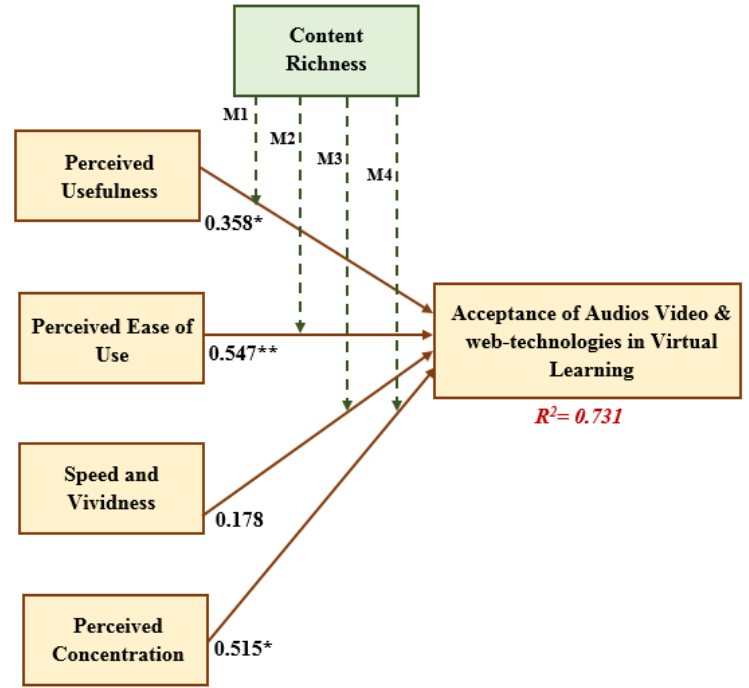
Fig. 2. Path coefficient of the model (significant at p** < = 0.01, p* <